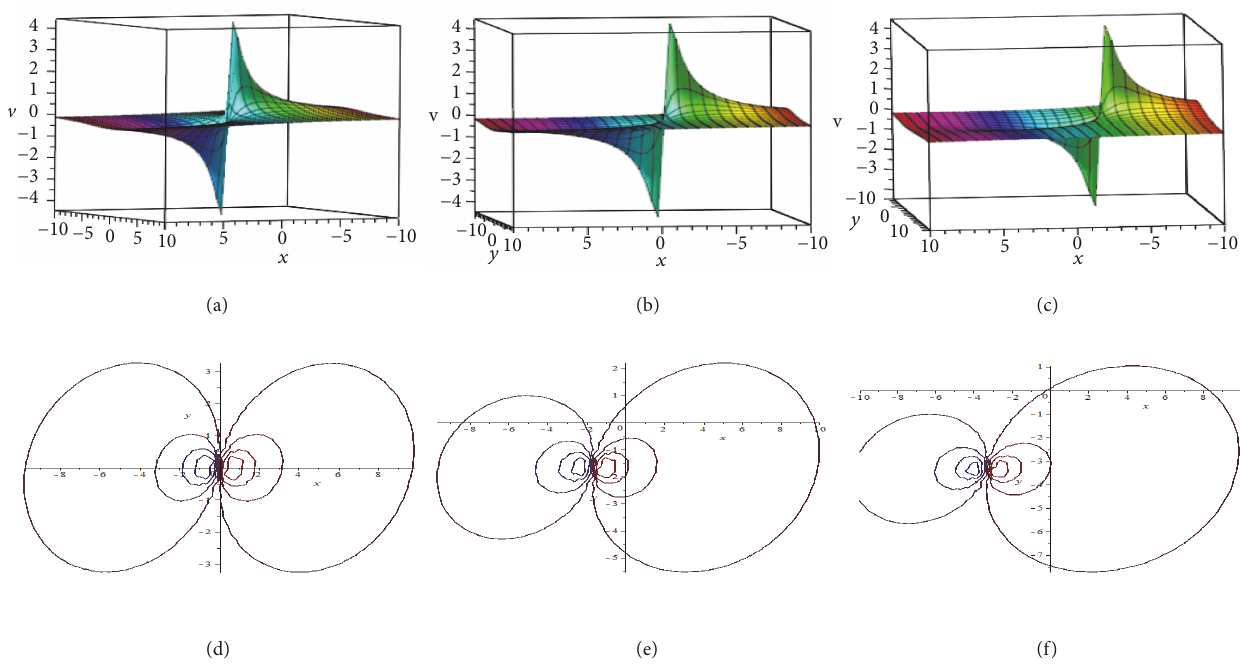
Figure 1: Top: 3D plots for (7) at (a) 𝑧 = 0 , (b) at 𝑧 = 5 , and (c) at 𝑧 = 10 . Nethermost: contour plots for (7) at (d) 𝑧 = 0 , (e) at 𝑧 = 5 , and (f) at 𝑧 =